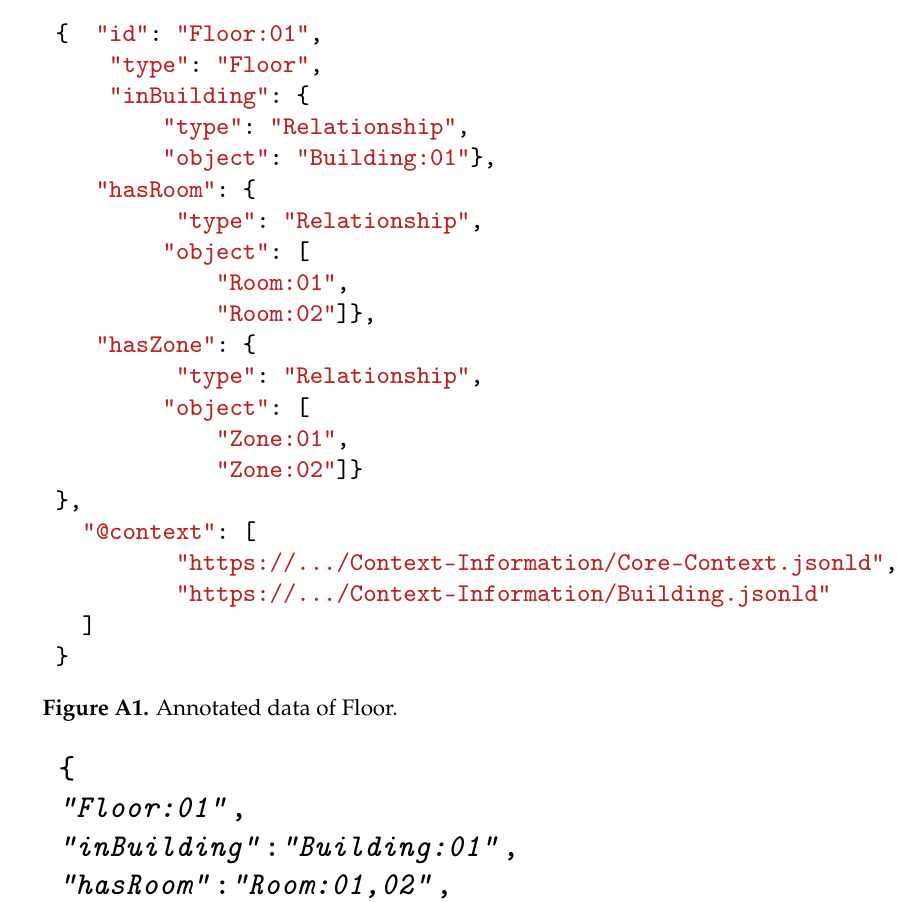
Figure A2. Raw data of Floor